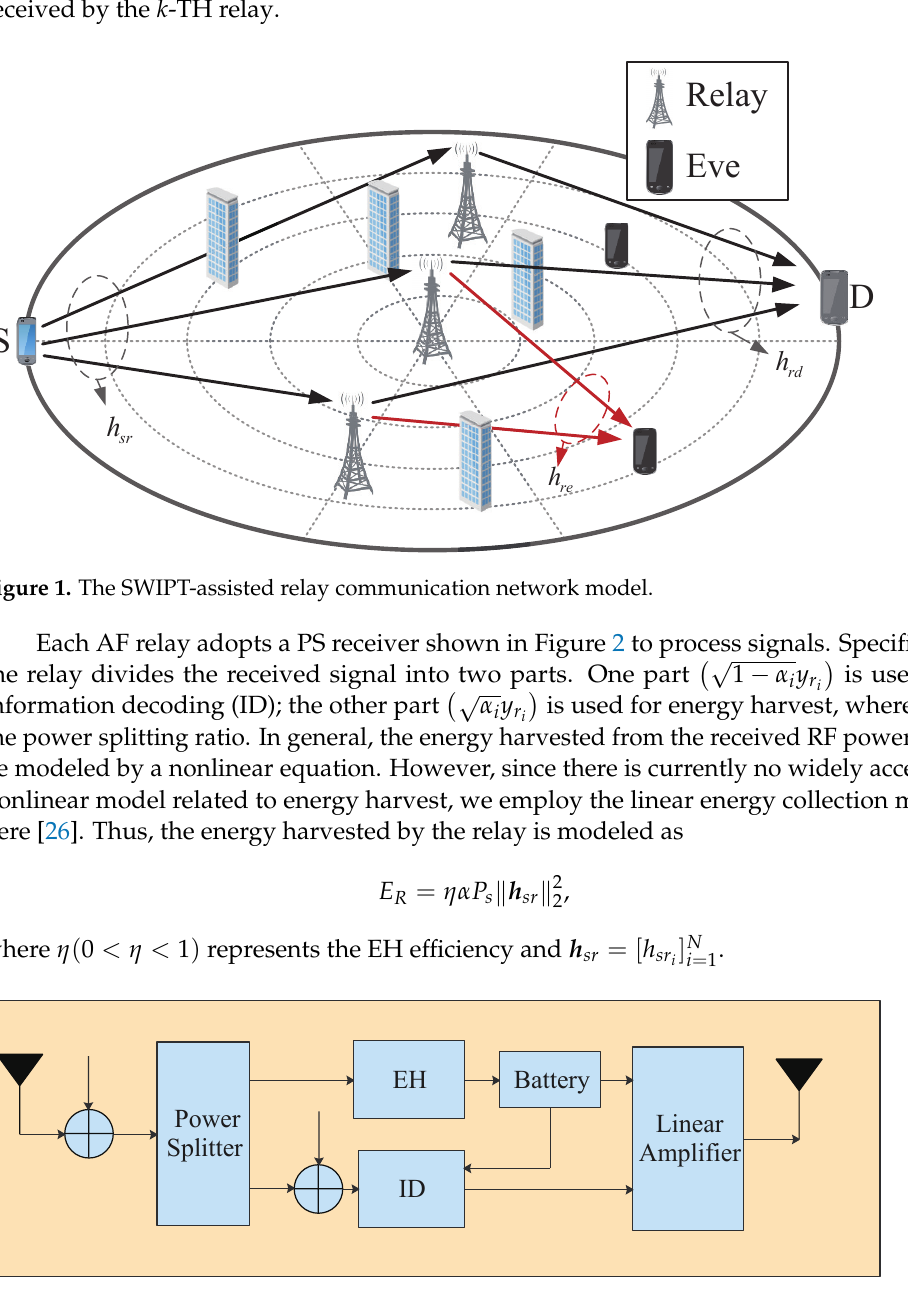
Figure 2. Power splitting receiver